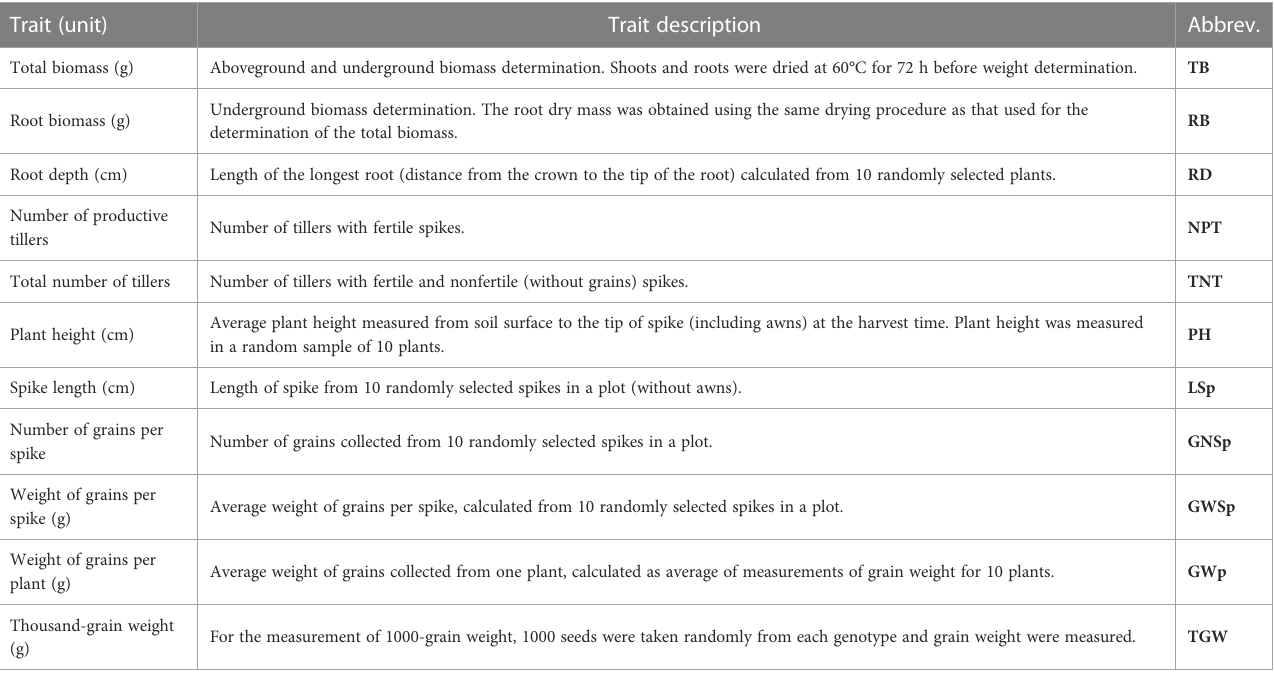
TABLE 3 List of phenotypic traits with description, abbreviations, and measured units. Trait (unit) Trait